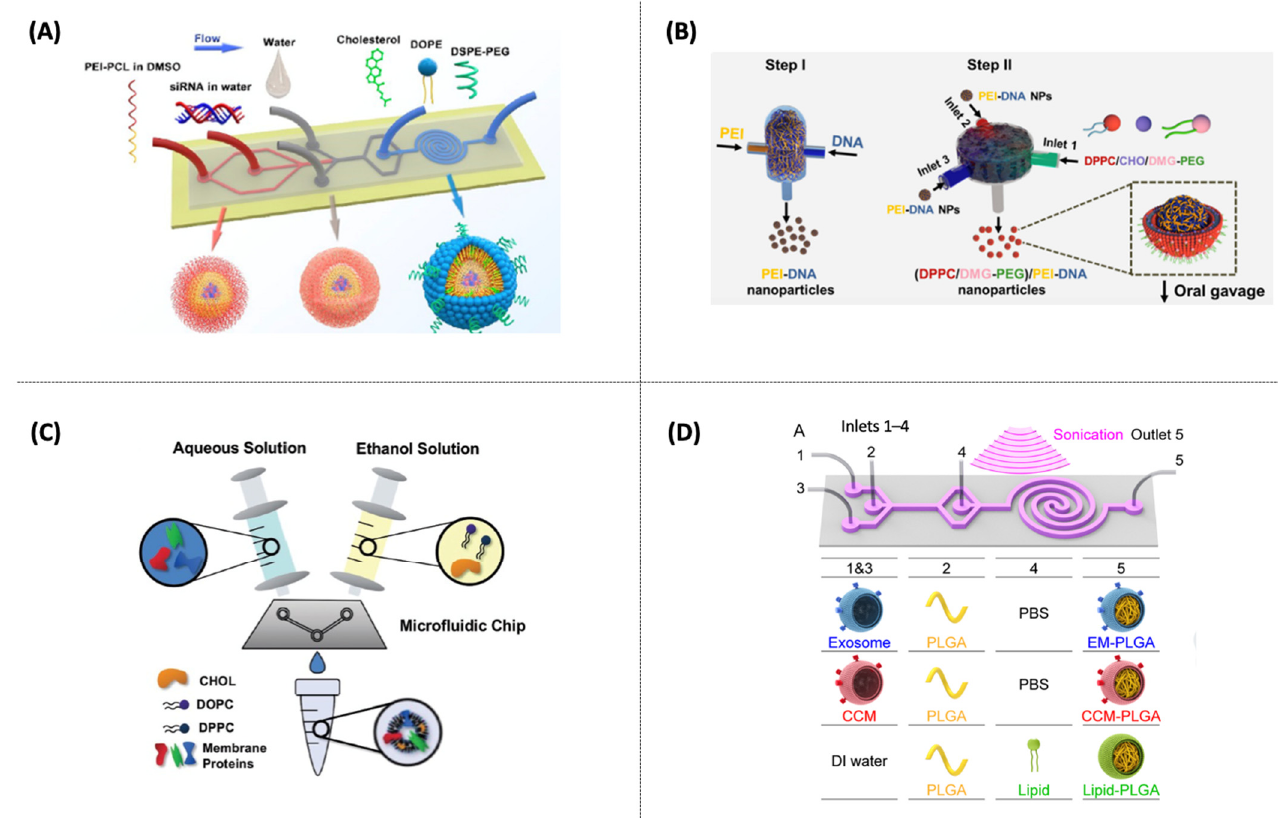
Figure 5. ( A ) Preparation of core-shell lipid/PCL-PEI/siRNA with the aid of a three-stage microflu- idic device [95]. ( B ) Schematic illustration of core-shell lipid/PEI-DNA nanoparticle preparation via flash nanocomplexation (FCN) using a confined impinging jet device (CIJ) and multi-inlet vortex mixer (MIVM) [96]. ( C ) Microfluidic HFF system used to produce biomimetic nanovesicles (Leuko- somes) [102]. ( D ) Schematic of one-step microfluidic sonication method to assemble biomimetic core—shell NPs (exosome membrane (EM), cancer cell membrane (CCM), and lipid—coated PLGA